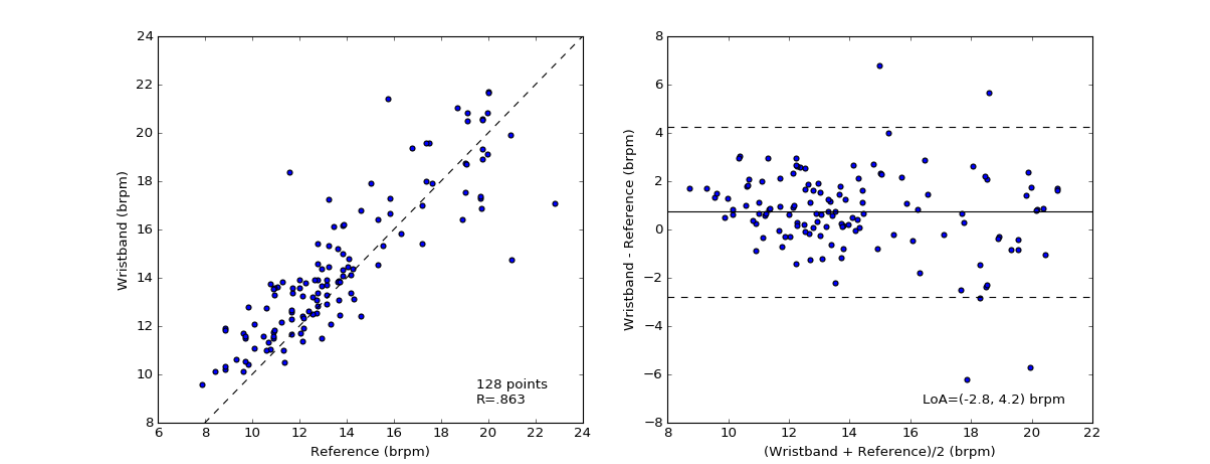
Figure 9. The distribution of measured respiration rate (RR) by spirometer and the wristband (left). Each data point represents the average RR over a 60-second nonoverlapping measurement window. Bland-Altman plots of the absolute error of RR between the wristband and the simultaneously recorded control measurements versus the mean of the measurements in breaths per minute (right). The solid black line indicates the mean difference. The dotted lines mark the 95% limit of agreement (LoA) at −3 and 4